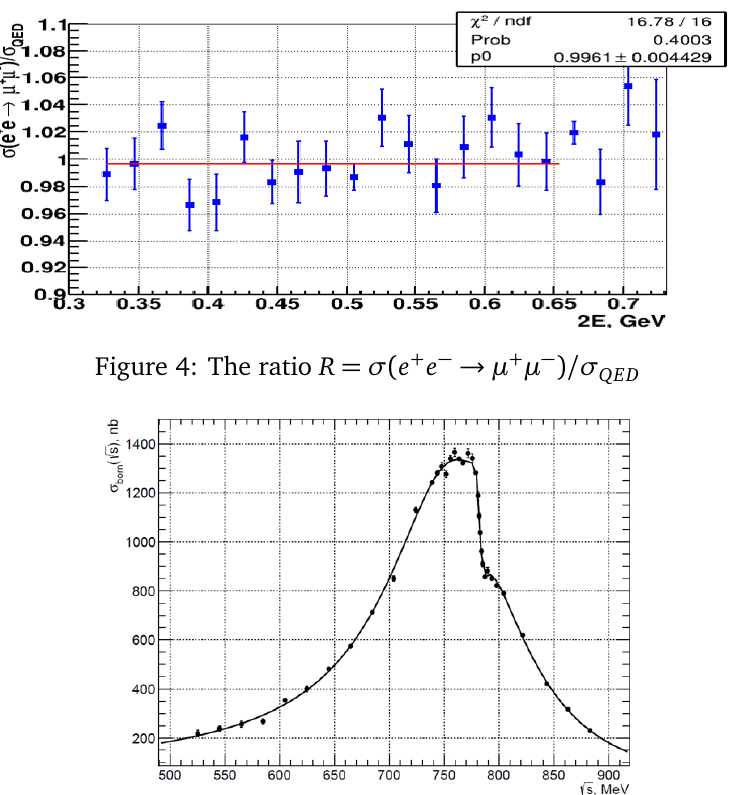
Figure 5: Preliminary results of the pion form factor measurements by SND exper- iment. The solid line correspond to the fit of the data by the ρ -meson shape with ρ − ω